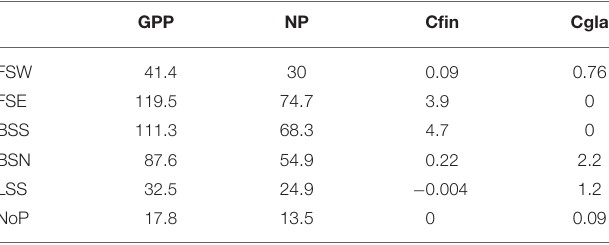
TABLE 2 | Annual Gross Primary Production (GPP), New Production (NP) and the production of Calanus finmarchicus (Cfin) and Calanus